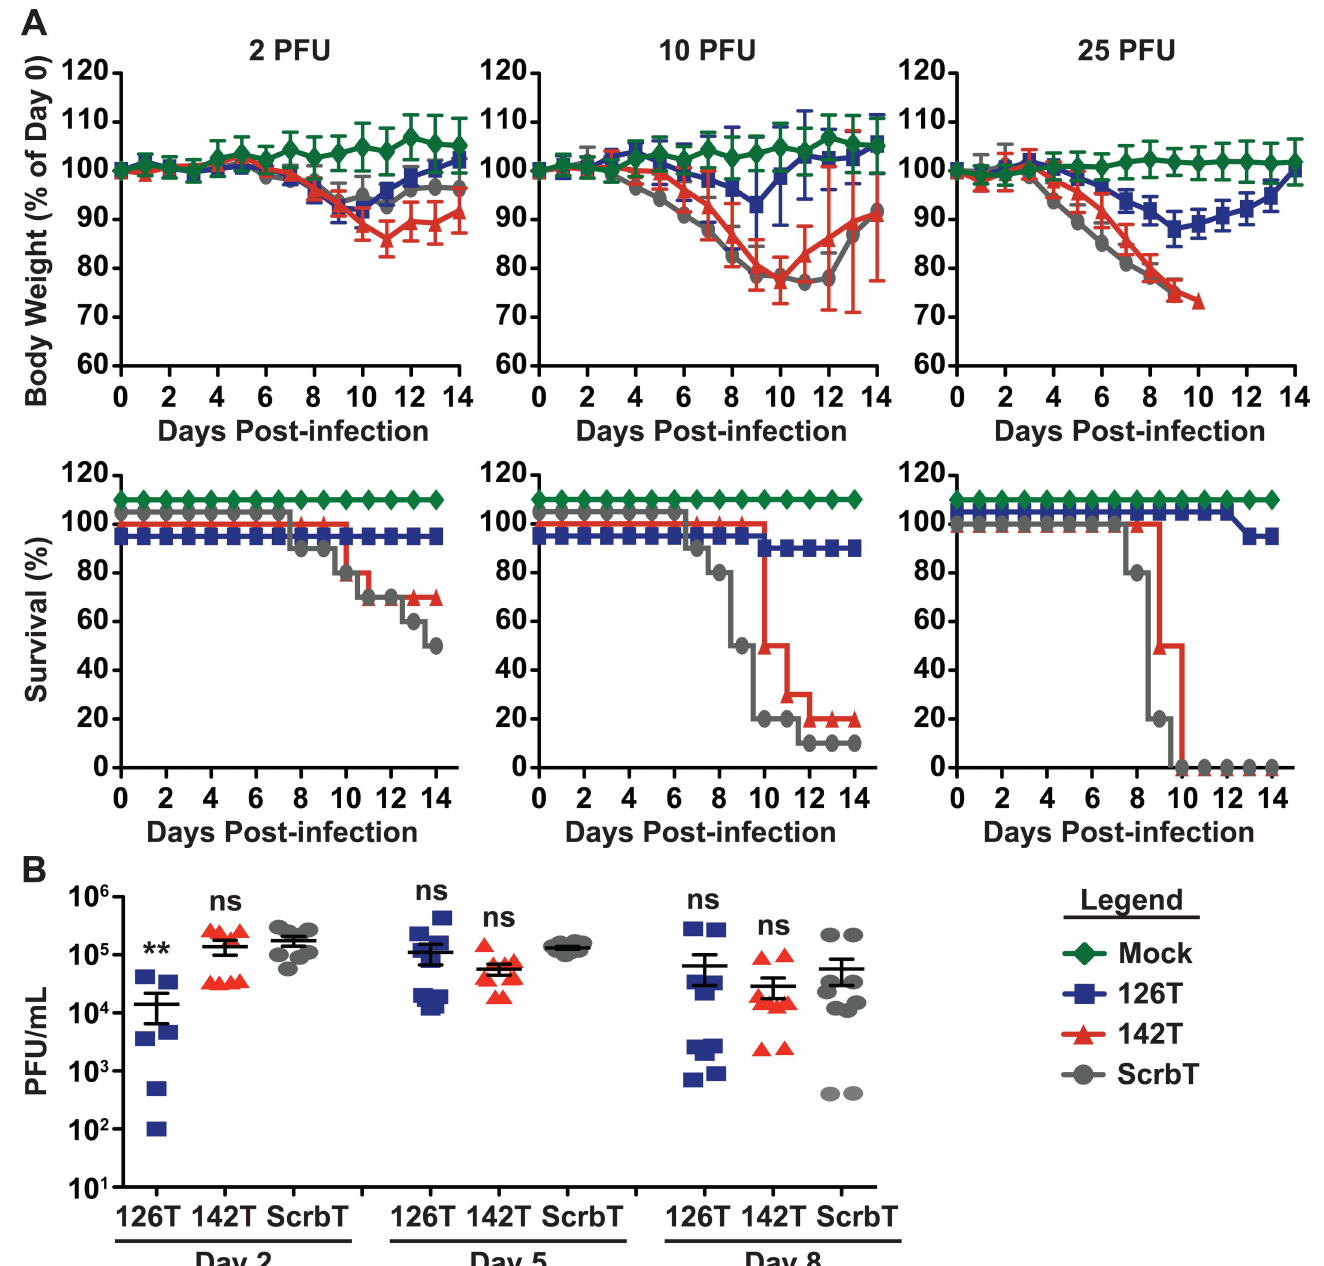
Fig 2. Restriction of H5N1 replication in endothelial cells ameliorates disease symptoms in mice. (A) C57BL/6Jmice (n = 10) were intranasally infected with different doses (2, 10, and 25 PFU) of tropism restricted H5N1 viruses and monitored daily for body weight and survival. Top—Body weight loss, shown as relative percentage of day 0 weight (mean ± SEM) and Bottom–Survival. For better display, survival lines are offset by a few percentagepoints. (B) Viral titers in the lungs of infected mice. C57BL/6Jmice (n = 6–10) were infected with 25 PFU and viral loads in the lungs on days 2, 5, and 8 pi were determined by plaqueassay (PFU/mL). Each data point represents an individual mouse (mean ± SEM). Asterisk denotes statistical significancedetermined by one-wayANOVA in comparisonto H5N1-ScrbTgroup and the values are denotedas * p < 0.05, ** p < 0.01, *** p < 0.001and ns–non significant.Data presented here is a pooledaverageof two independent experiments. cells. We observed a higher percentage of HA positive endothelial cells (CD45 - CD31 + ) in H5N1-ScrbT and H5N1-142T infected mice as compared to H5N1-126T infected mice (Fig